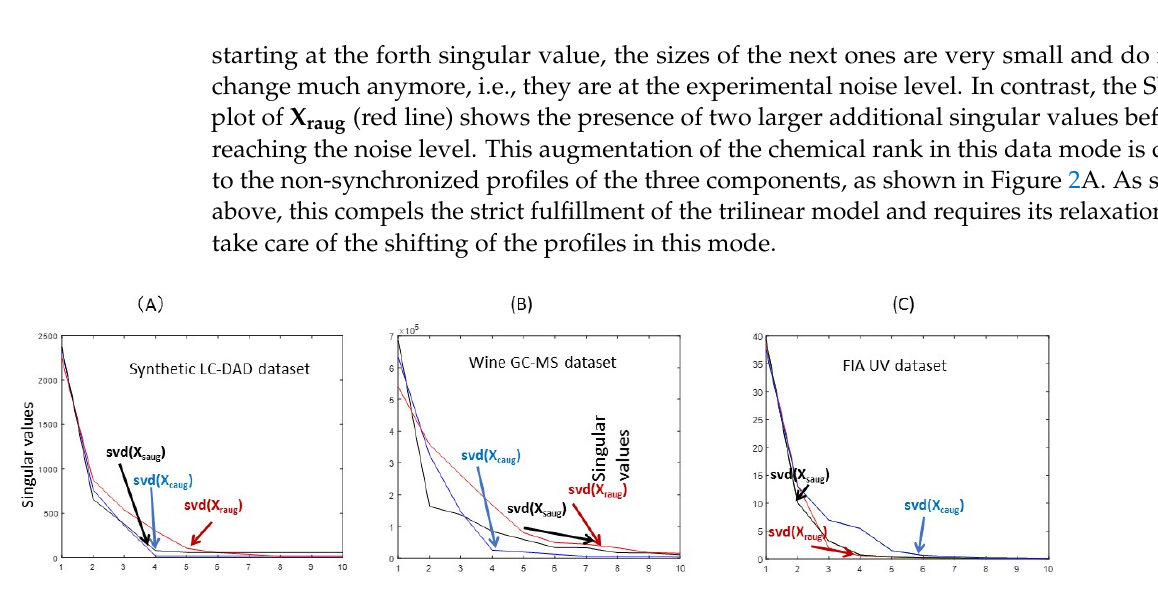
Figure 3. SVD results in the analysis of the three augmented data matrices X caug , X raug and X saug along the three data modes for the three investigated data examples: ( A ) Synthetic LC-DAD dataset; ( B ) Wine GC-MS data set; ( C ) FIA UV dataset.